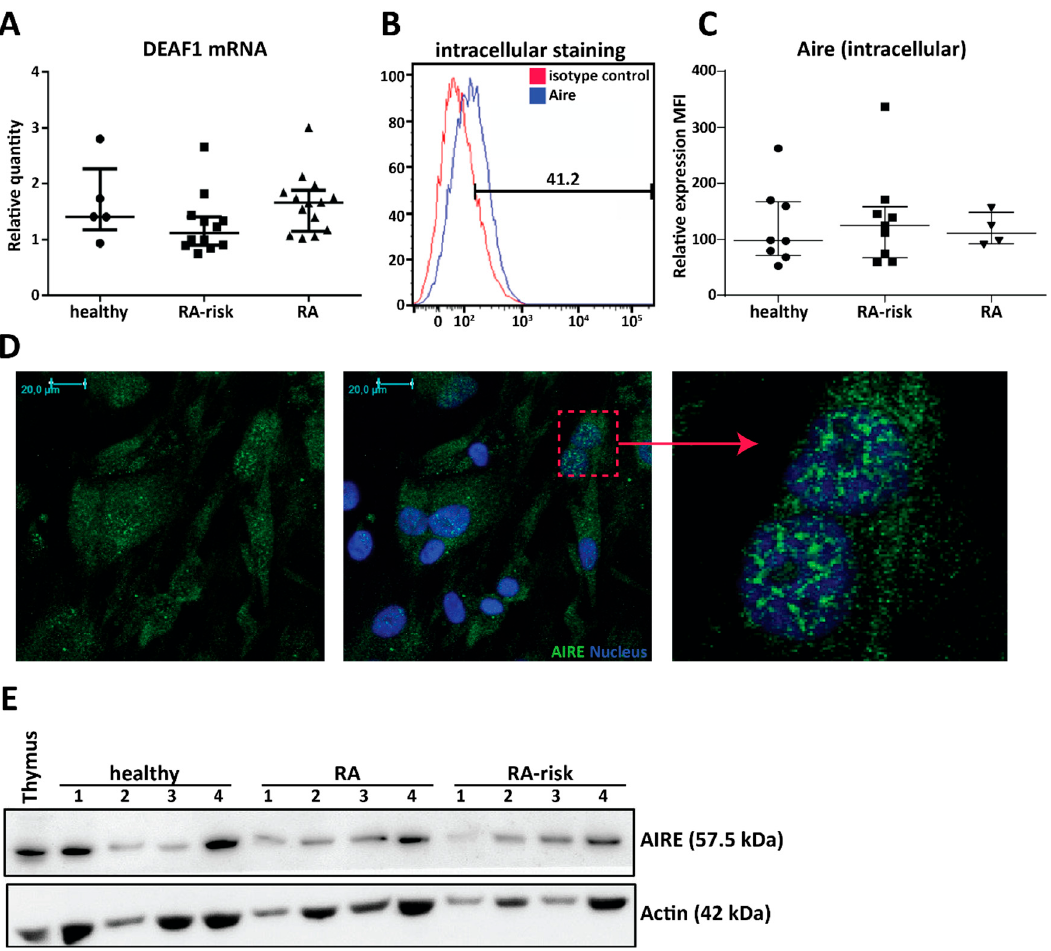
Figure 2. Expression of the peripheral tissue antigen (PTA) driving transcription factors autoimmune regulator (AIRE) and deformed epidermal autoregulatory factor 1 (DEAF1) in human LNSCs. ( A ) Expression of DEAF1 in cultured LNSCs of passage 2 was assessed by qPCR and compared between different donor groups (healthy individuals n = 5, RA-risk individuals n = 12 and RA patients n = 14). Relative quantity is displayed as median and interquartile range. ( B ) Intracellular expression of AIRE protein in cultured LNSCs was measured by flow cytometry. Histograms presenting % of positive cells in comparison to isotype staining. ( C ) The scatter plot represents the mean fluorescence intensity (MFI) of intracellular AIRE expression in cultured human LNSCs (passages 3–5) from individuals in different donor groups (healthy individuals n = 8, RA-risk individuals n = 9 and RA patients n = 4). Relative quantity is presented as median and interquartile range. ( D ) Representative pictures of immunofluorescence staining combined with confocal microscopy displaying AIRE (green) and nucleus (blue) in LNSCs (RA patient; passage 3) cultured on chambers slides. Isotype controls were negative. ( E ) Western blot analysis of AIRE protein expression in cultured LNSCs of 12 donors (passages 4–8) is shown. Actin was used as loading control and thymic tissue was used as positive control for AIRE expression.